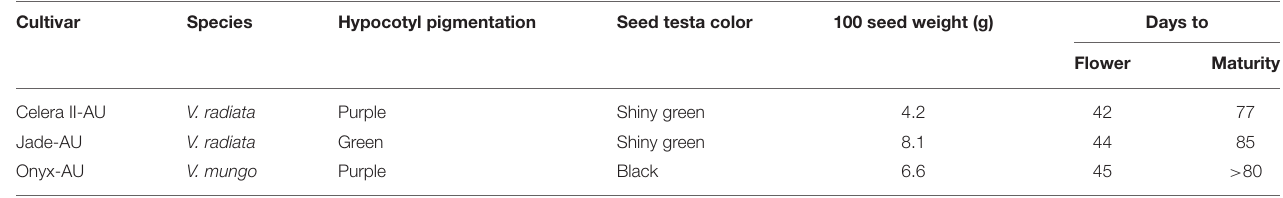
TABLE 1 | Hypocotyl pigmentation and testa color, 100 seed weight, and days to flowering and maturity in two mungbean genotypes (Celera II-AU and Jade-AU) and a blackgram genotype (Onyx-AU). Cultivar Species Hypocotyl pigmentation Seed testa